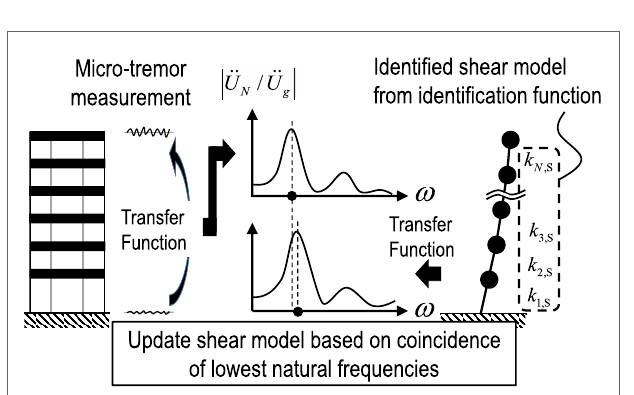
FIGURE 5 | Refinement of limit value of identification function by using identified shear model .